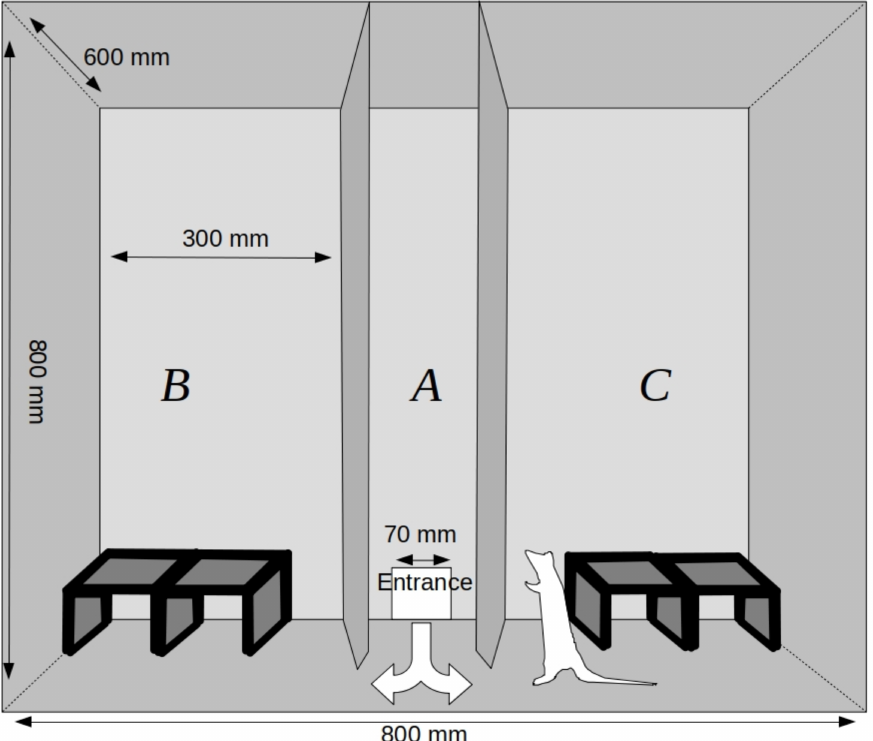
Figure 2. The experimental chamber of the free-exploration test—frontal view through the transparent front wall.